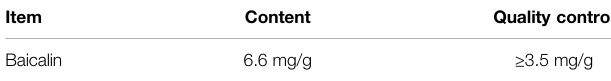
TABLE 5 | Quality analysis of FLKM. Item Content Quality